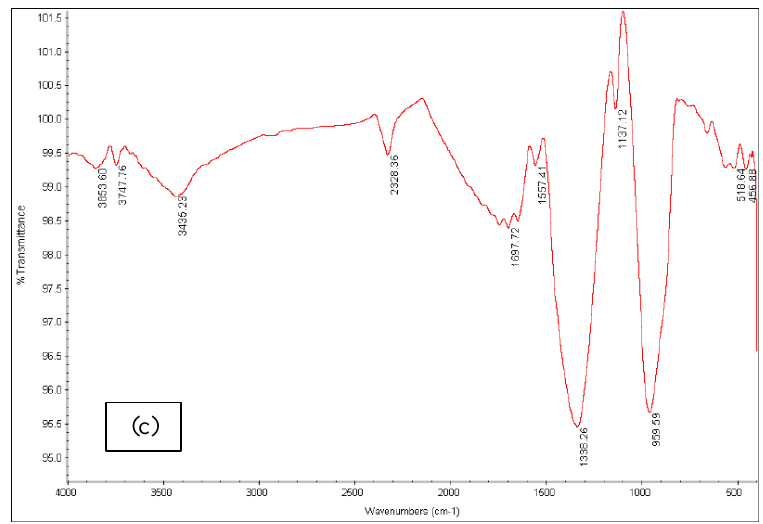
Figure 2. FT-IR spectra of powder samples of nanocatalyst (a) T, (b) TZ2(c)TZ4. Table 2. FT-IR spectroscopy results Of TiO 2 and Zr doped-TiO 2